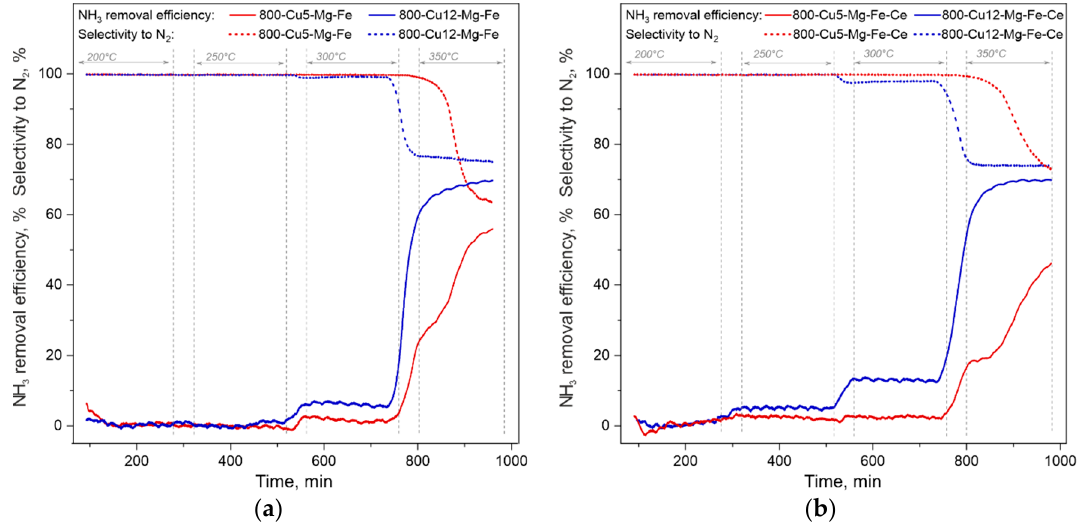
Figure 7. Results of selective catalytic oxidation of ammonia to dinitrogen over ( a ) 800-Cu5-Mg-Fe and 800-Cu12-Mg-Fe catalysts; ( b ) 800-Cu5-Mg-Fe-Ce and 800-Cu12-Mg-Fe-Ce; solid line—ammonia removal efficiency (%), dotted line - selectivity to dinitrogen (%); temperature ranges marked by a vertical, dotted gray line.